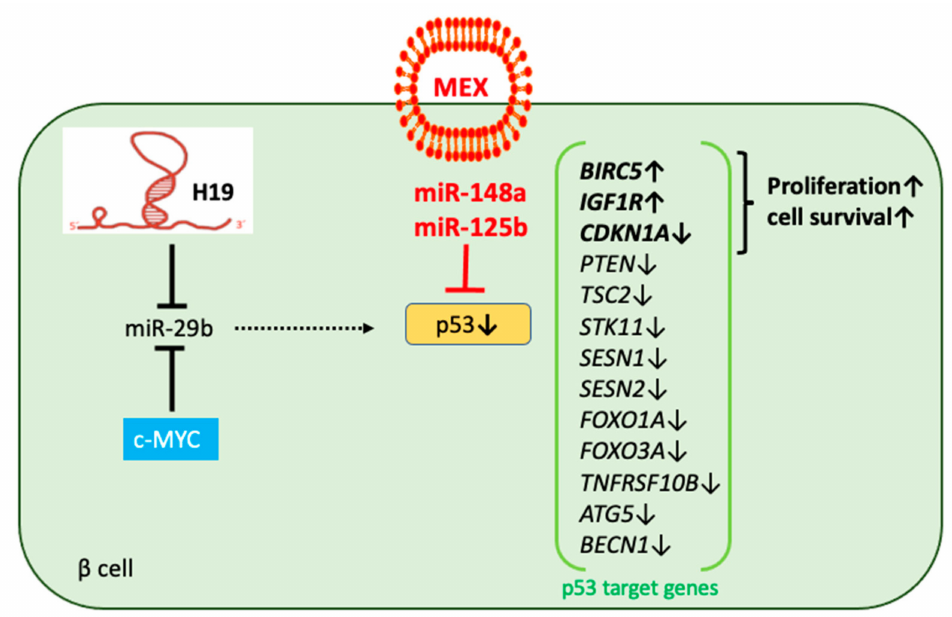
Figure 4. The predicted impact of milk miR signaling on β cell p53-dependent gene expression. Milk exosome (MEX)-derived miR-148a and miR-125b are abundant miRs of human and bovine milk that target p53. Reduced p53 signaling may modify genes involved in cell proliferation ( CDKN1A , IGF1R ) and survival ( BIRC5 ). Enhanced expression of long non-coding RNA H19 and transcription factor c-MYC reduces the expression of miR-29b, a positive regulator of p53